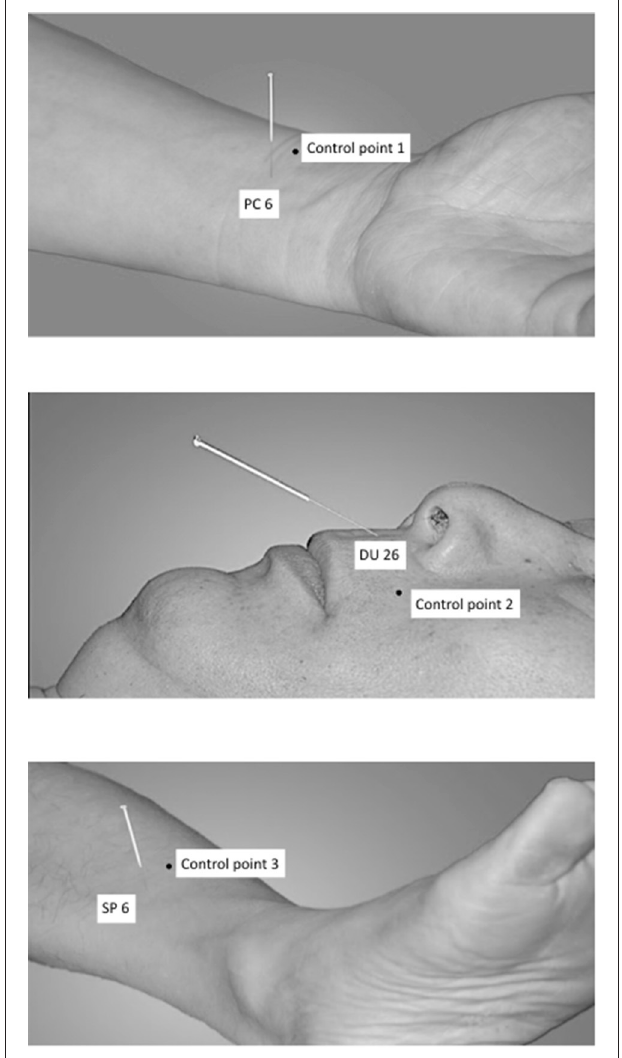
FIGURE 1 | Acupuncture points and respective control